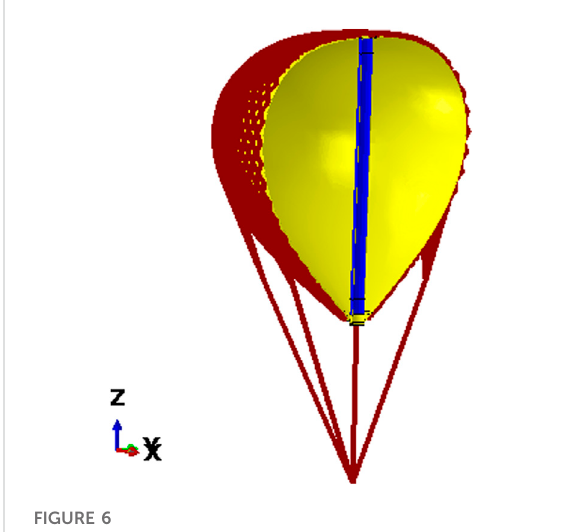
FIGURE 6 Outline of the ABAQUS model for the fl exible tank.